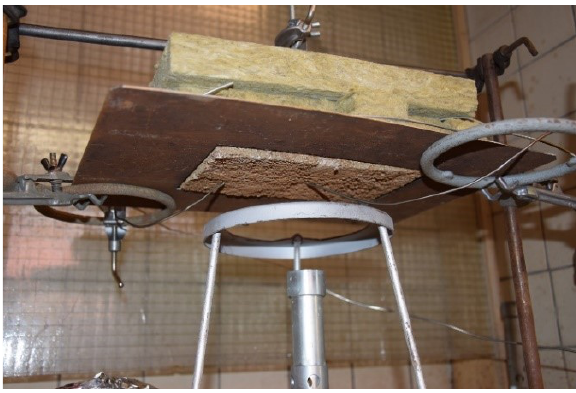
Table 2. Simulation material